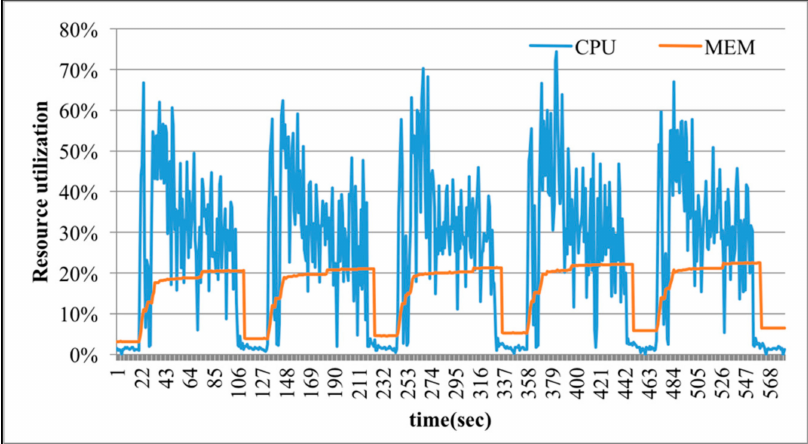
Figure 10. Resource utilization of executing SparkTC when over-commit with 64 vCPU